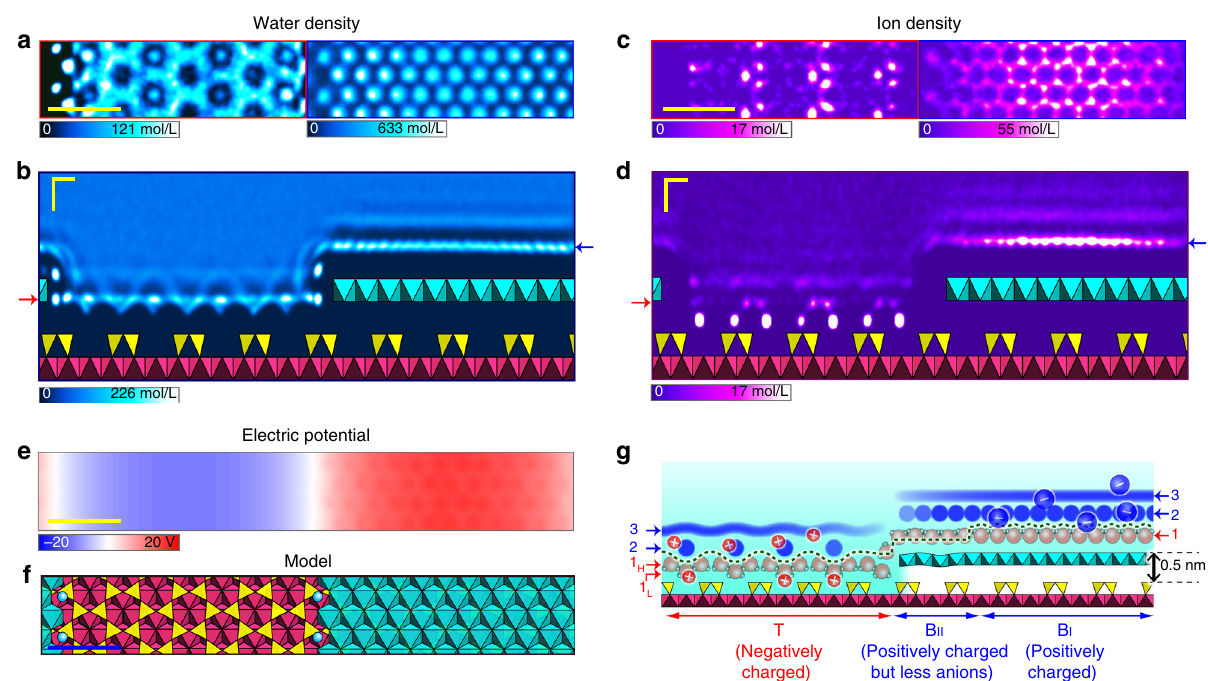
Fig. 5 Theoretical local hydrations and ions around the step edge. a , c Lateral water (oxygen) ( a ) and ion ( c ) density maps from the MD simulation in the fi rst layers on the T and B regions. b , d Perpendicular water ( b ) and ion ( d ) density maps averaged along the [001] direction, where the arrows indicate the heights of the lateral water density maps in a and c , respectively. e Electric potential of 0.1 nm above the outermost oxygen atoms of the B region (showing a zero potential at the step edge, in white). f Structural model used in the MD simulation. g Schematic illustration of the cross section of the clinochlore (001) surface along the dashed lines in Fig. 4a, b. The green dashed curve shows the apparent surface (trajectory of the tip scan during imaging topography). Scale bars: 1.0 nm ( a , c , e ) and 0.3 nm ( b , d